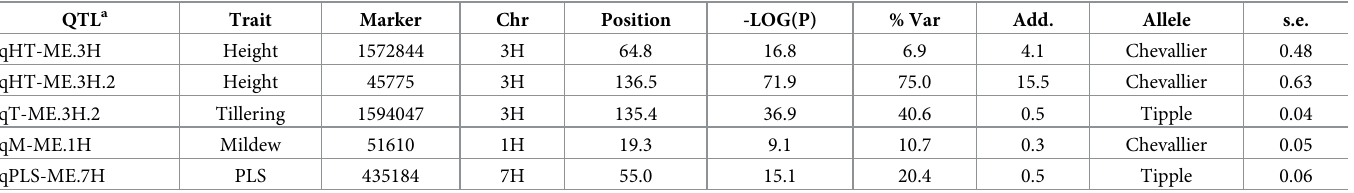
Table 3. Stable agronomic trait QTL identified from single-trait, multiple-environment QTL analysis in the Chevallier × Tipple F 7 RILs. QTL a